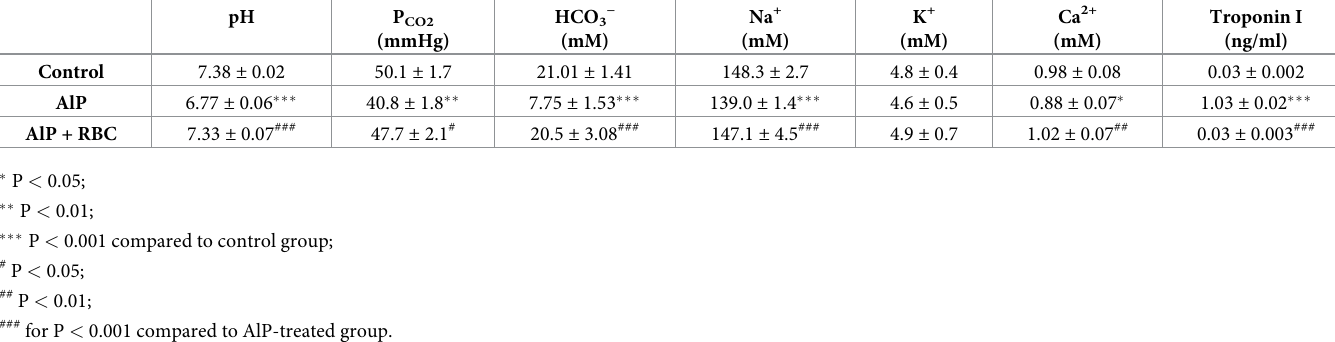
Table 2. Effects of fresh packed red blood cells (RBC) on blood pH, P CO2 , plasma electrolytes and troponin I. Values are expressed as mean ± S.E.M.